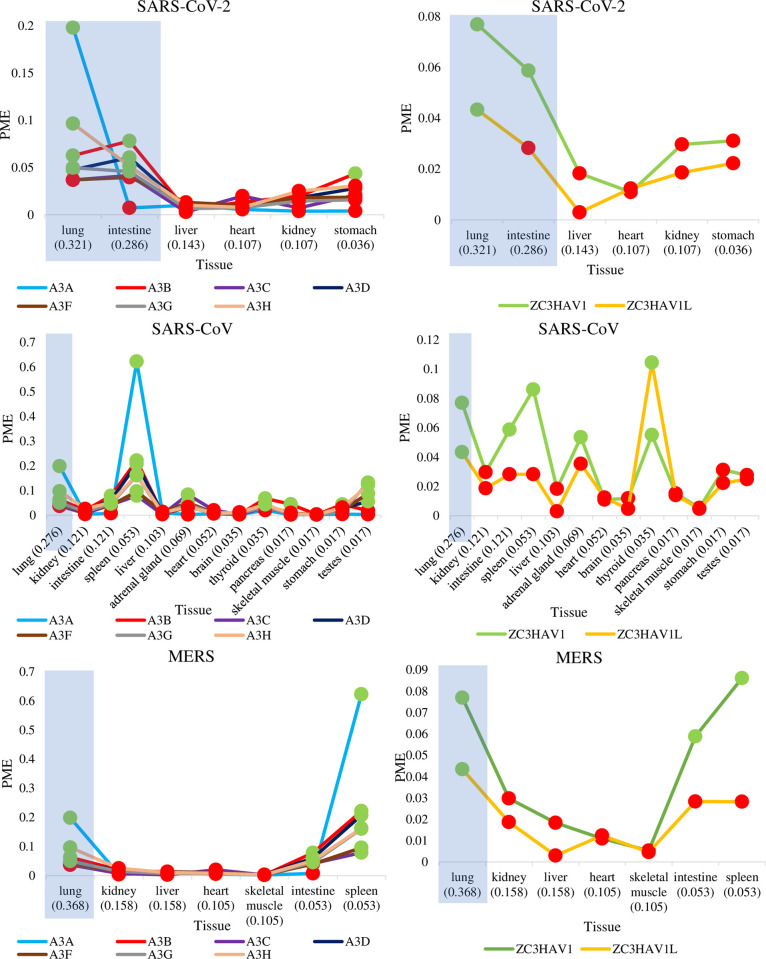
Tissues that are regularly infected by SARS-CoV-2, SARS-CoV, and MERS also have high mRNA expressions of APOBEC3 and ZAP AVPs.The lines show the relative mRNA expressions in PME, for each APOBEC3 and ZAP isoform, among tissues having records of SARS-CoV-2, SARS-CoV, and MERS infections. Dots highlighted in green and red are PME values that are greater and lower than the averaged PME values, respectively. These PME values were calculated based on averaged mRNA FPKMs retrieved from the GTEx Portal [61]. For each tissue, the commonness of viral detection (COD) score is appended in brackets next to tissue name. Shaded in light blue-gray are tissues that were determined to be regularly infected by the coronavirus (based on highest COD scores).